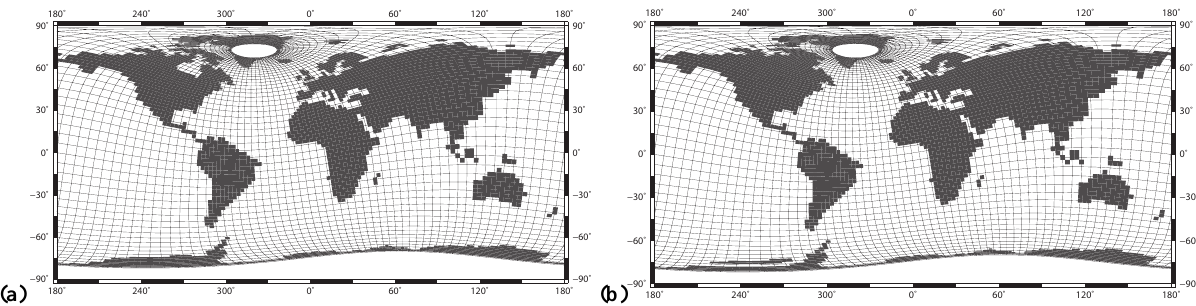
Fig. 1. Land-sea distribution on the ocean model grid as used in the PMIP3 PI control simulation (a) and the PlioMIP mid-Pliocene simulation (b) of experiment 2. There are two grid poles (white areas) which are located over Greenland and Antarctica. The nominal grid resolution of 3 ◦ × 1 . 8 ◦ of the 122 × 101 grid varies; it is high in polar regions and highest around Greenland. Both land-sea distributions are identical with the exception of the closure of the Hudson Bay and modifications in the West Antarctic in the case of the mid-Pliocene experiment. For clarity, only every second grid line is shown in the graph.